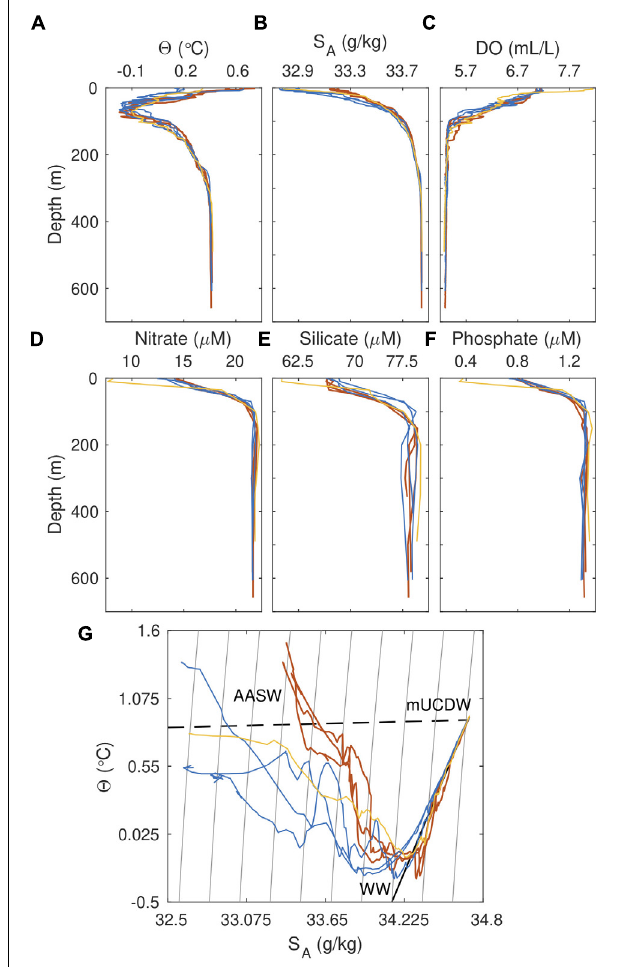
FIGURE 3 | Profiles of (A) temperature, (B) salinity, (C) dissolved oxygen, (D) nitrate, (E) silicate, and (F) phosphate for occupied stations. Colors are as indicated in Figure 1C . (G) Temperature-salinity diagram for hydrographic stations. Gray lines indicate isopycnals, while the dashed and solid black lines correspond to the runoff and meltwater mixing line, respectively. Major water masses present in the region are indicated in black text. WW, Winter Water; mUCDW, modified Upper Circumpolar Deep Water; AASW, Antarctic Surface